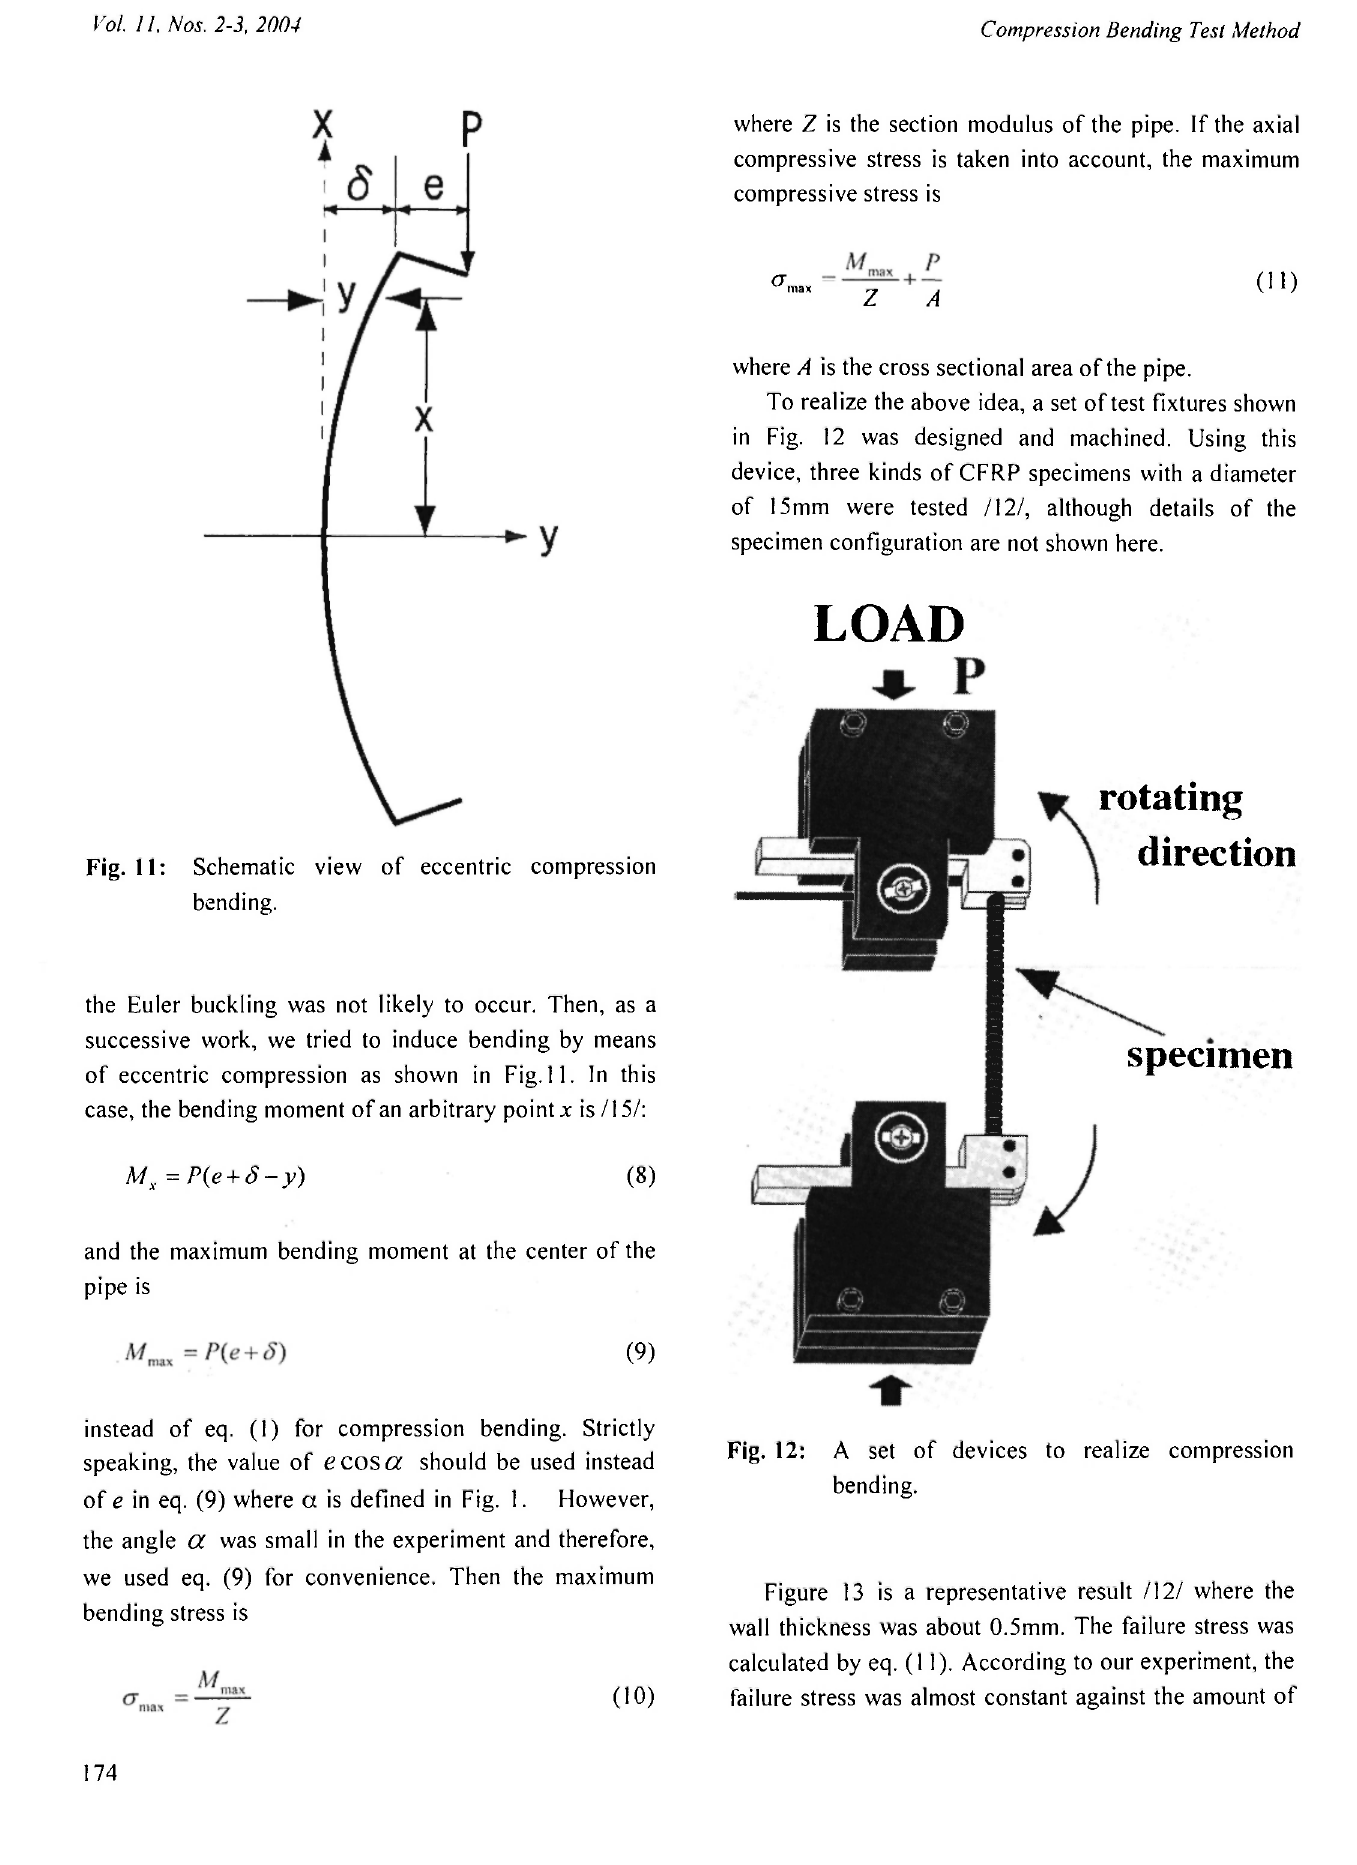
Fig. 11 : Schematic view of eccentric compression bending.